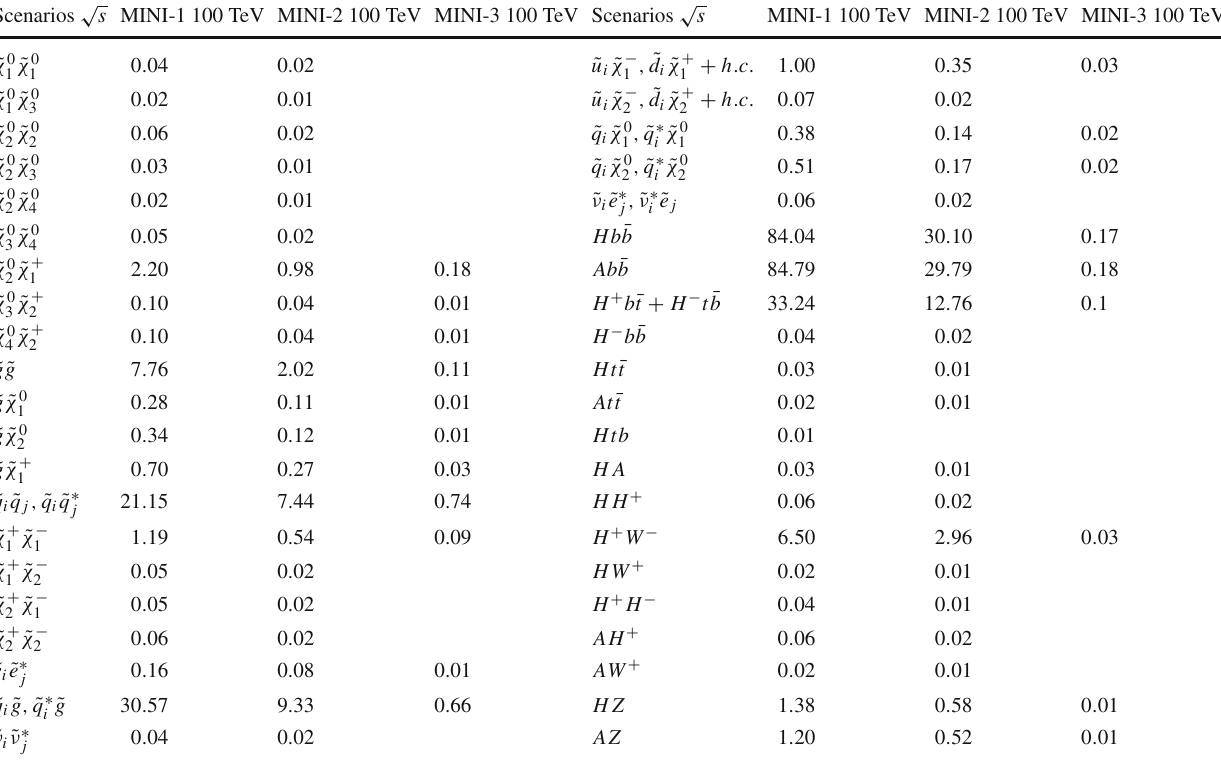
Table 3 Expected production cross sections (in fb) for SUSY particles in the MINI scenarios. There are no channels with cross sections exceeding √ s = 14 0.01 fb at